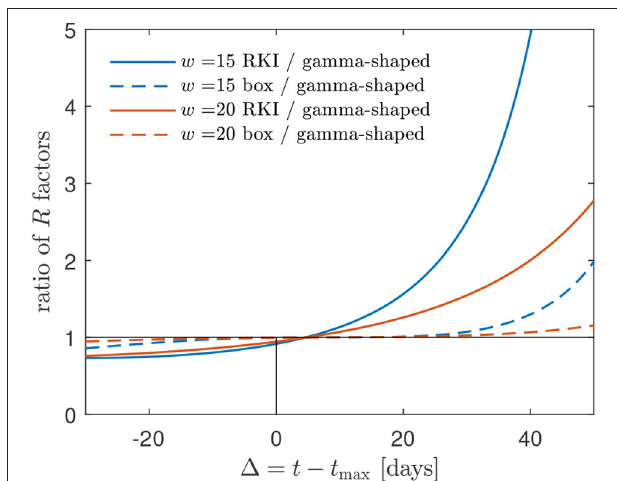
FIGURE 6 | The R ( t ) factors obtained using (i) the box-shaped W ( s ) and (ii) the RKI formula greatly overestimate the R ( t ) using a gamma-shaped serial interval distribution at times beyond the peak time. Alternative representation of the data already shown in Figure 5 . The mismatch increases with decreasing w . A typical w is in the range between 15 and 20 days for most countries [ 1] (cf. Figure 1